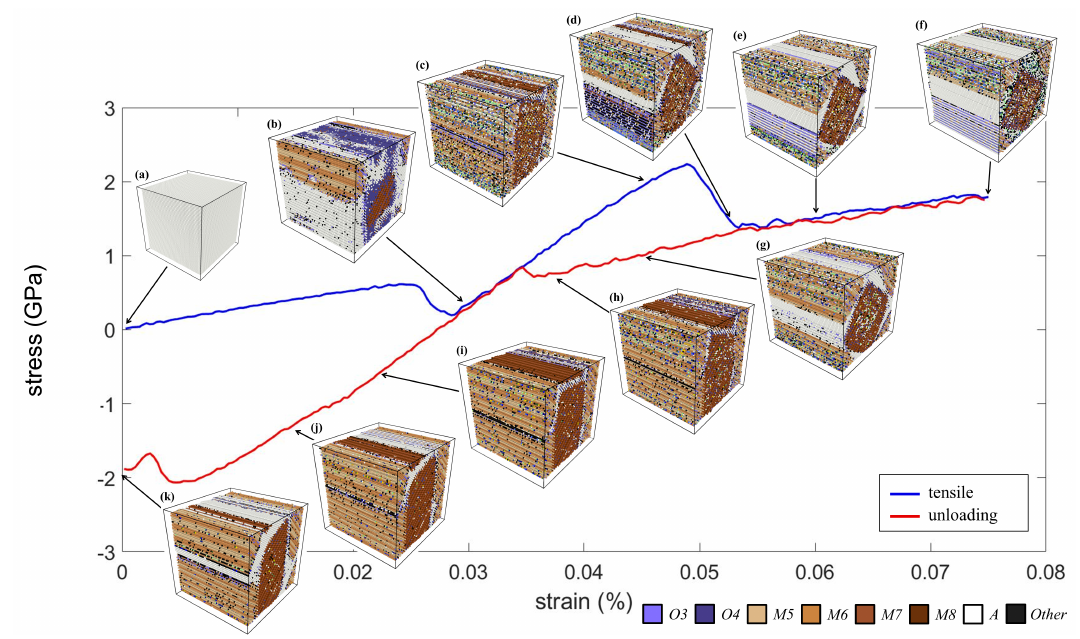
Figure 6. The stress–strain curve of the NiTi SMA subjected to tensile loading. The corresponding microstructures at Stages ( a – k ) are shown.